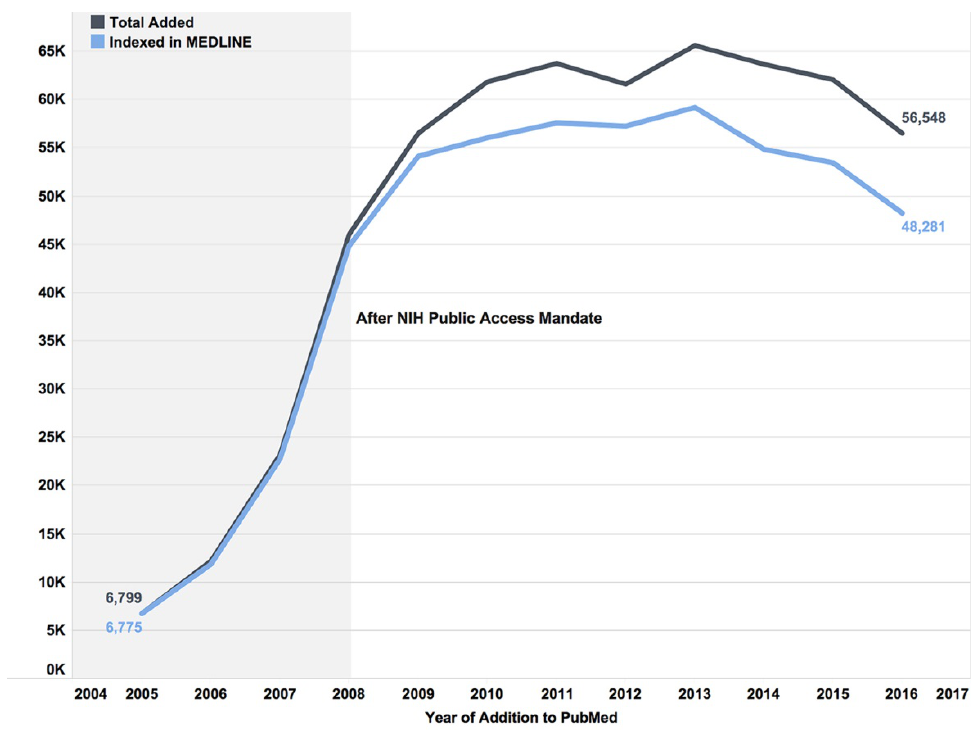
Figure 6 New author manuscript records added to